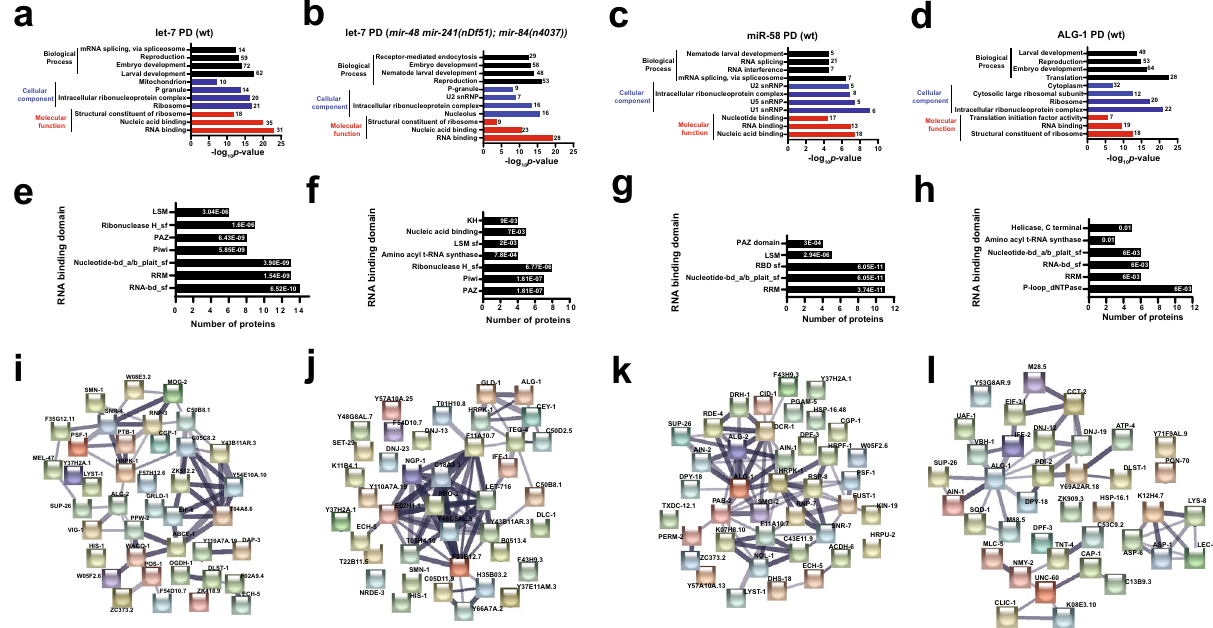
Figure 2. miRNA pulldowns identify components of translation machinery and mRNA processing factors, which may form a functional network. ( a – d ) Terms identified through GO analysis for biological processes (top four), cellular components (top four) and molecular function categories (top three) among let-7 PDs in ( a ) wild type, ( b ) mir-48 mir-241(nDf51); mir-84(n4037) backgrounds, ( c ) miR-58 PD and ( d ) ALG-1 IP 19 . Total number of proteins classified under each term shown adjacent to respective bars. ( e–h ) RNA binding domains identified in factors captured in let-7 PDs from ( e ) wild type, and ( f ) mir-48 mir-241(nDf51); mir-84(n4037) ) backgrounds, ( g ) miR-58 PD and ( h ) ALG-1 IP. The FDR adjusted p-values for enrichment of proteins harboring individual domains are shown within the respective bars. ( i – l ) The reproducibly enriched proteins form functional network. Network analysis was performed using STRING 28 on top 40 enriched interactors in ( i ) let-7 PD (wild type), ( j ) let-7 PD ( mir-48 mir-241(nDf51); mir-84(n4037)) ( k ) miR-58 PD and ( l ) ALG-1 IP. Ribosomal proteins were excluded from this analysis. Thickness of edges represents degree of confidence of functional linkages. The number of edges is significantly higher than expected, with a p -value <